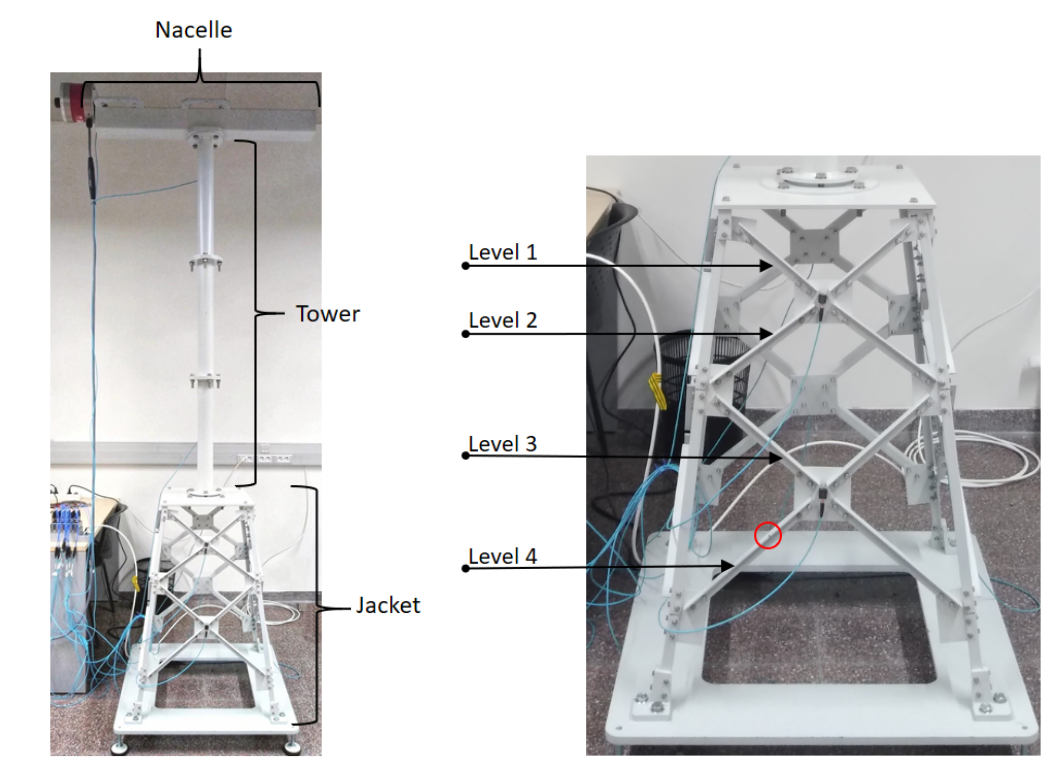
Figure 4. WT scaled offshore fixed jacket-type platform tower model used in the experimental tests (left). Bars (pointed with arrows) where the crack damage is introduced (right); note that in this picture the damage is introduced at level 4 (red circle), but it will be introduced on each level one by one.